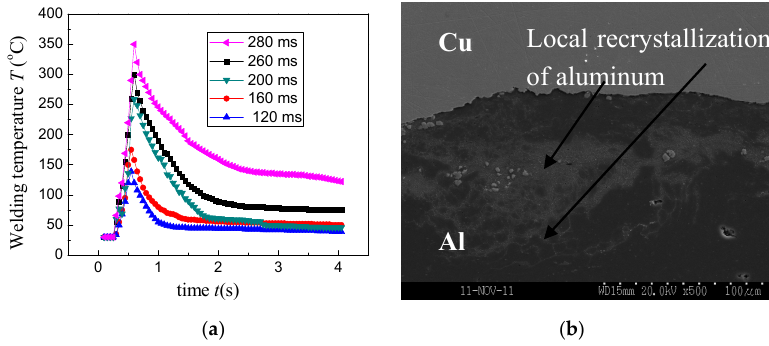
Figure 7. ( a ) Welding temperatures vs. welding durations, static pressure 7.2 MPa ( b ) Local recrystallization of aluminum.